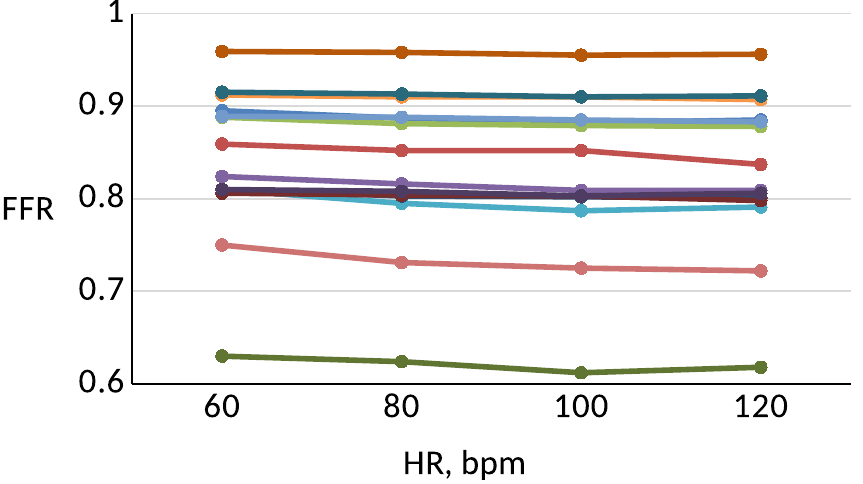
Figure 8. FFR for various heart rates, which was calculated for the full trees by the recursive algorithm.